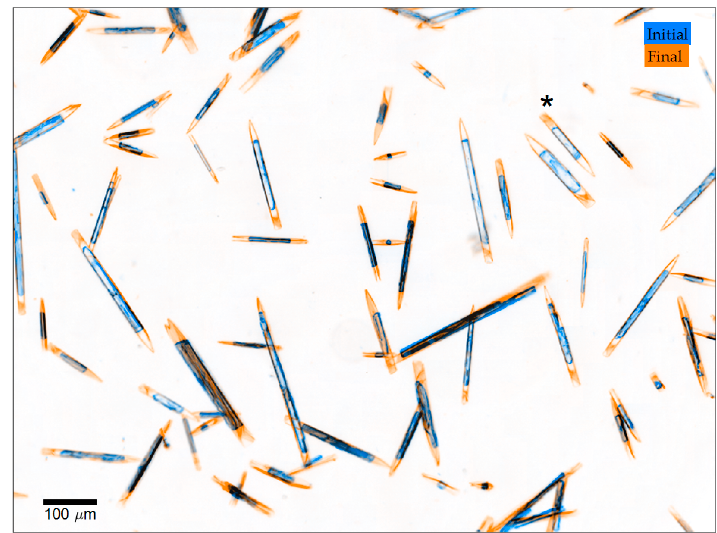
Figure A2. The initial and final frame from a growth experiment are overlaid, with the initial crystals in blue and the final crystals in orange (there complete overlap makes black). The * indicates the crystal examined in detail in Figure A3.